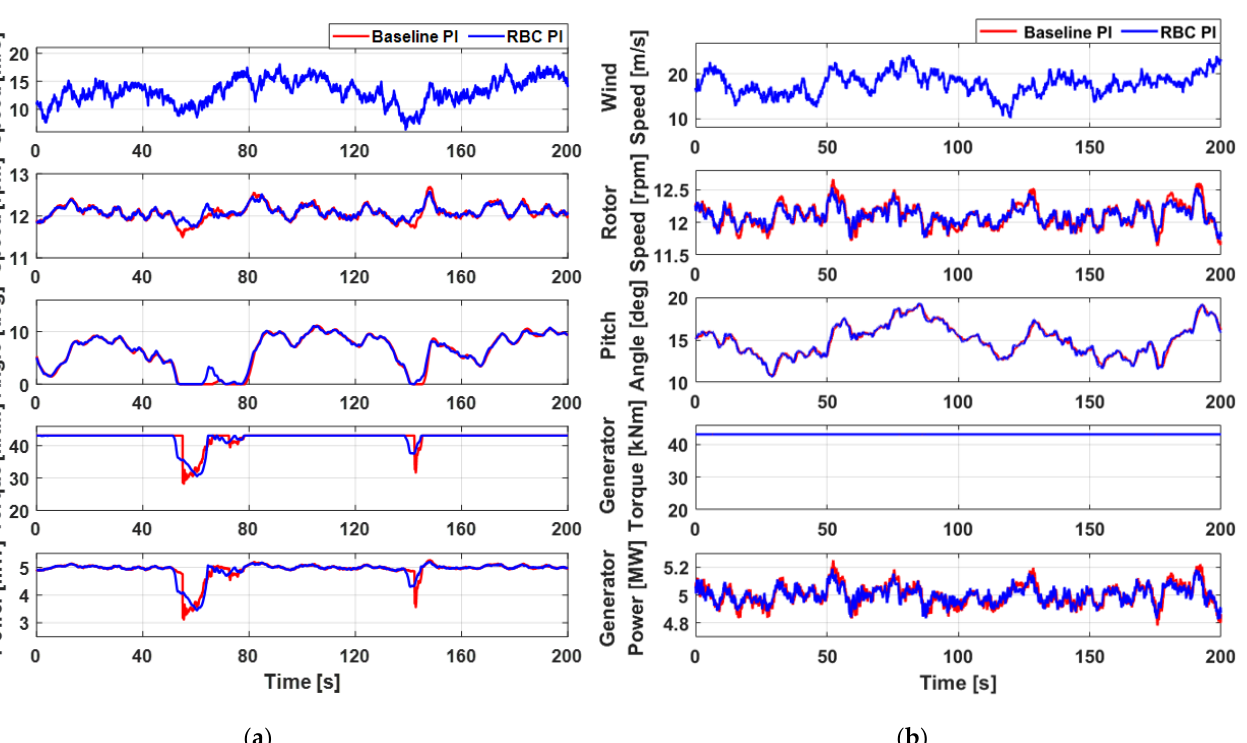
Figure 7. Results from HILS testing of NREL 5MW wind turbine: ( a ) average wind speed of 13 m/s and 19% turbulence intensity; ( b ) average wind speed of 18 m/s and 17% turbulence